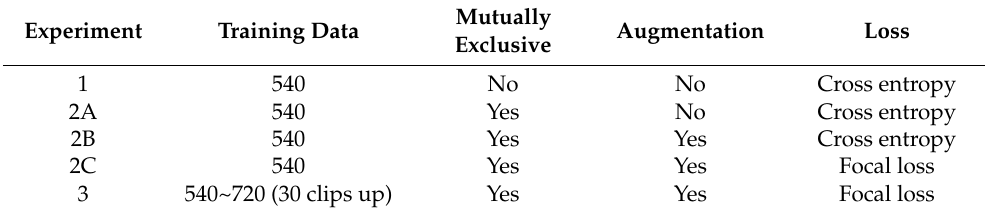
Table 1. The conditions and number of datasets for Experiment 1, Experiment 2, and Experiment 3.